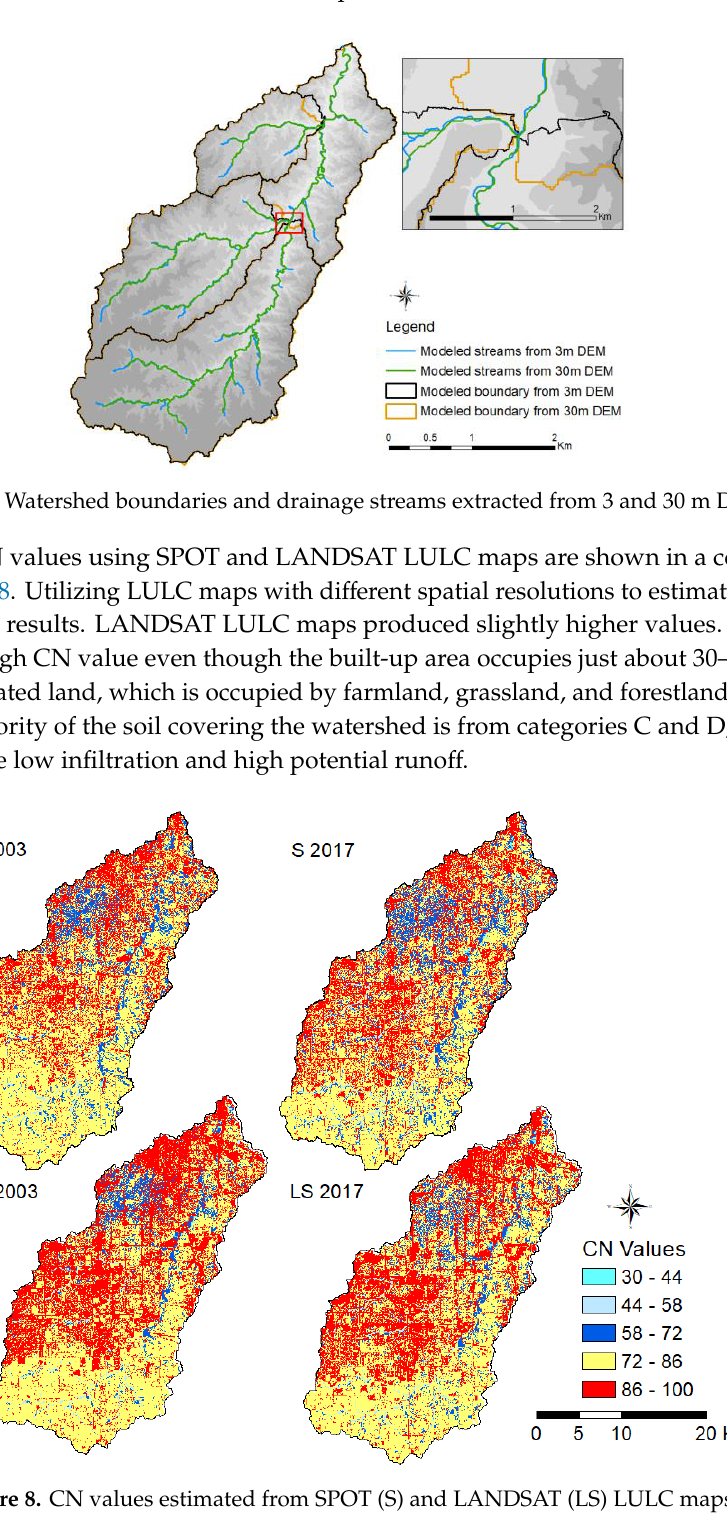
Figure 8. CN values estimated from SPOT (S) and LANDSAT (LS) LULC maps.